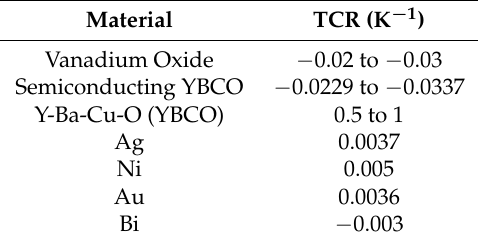
Table 1. Temperature coefficient of resistance of some materials [87].